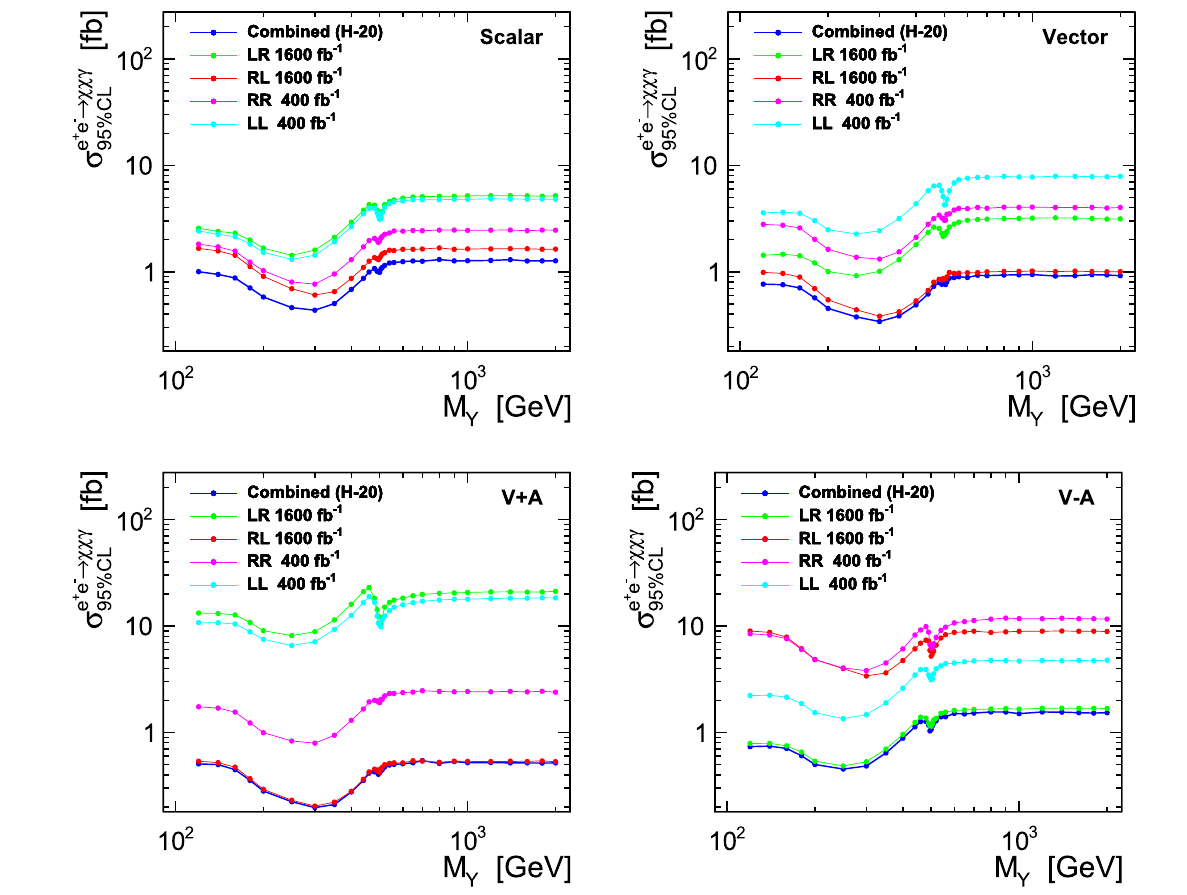
Fig. 9 Limits on the cross section for the radiative light DM pair-production processes with s -channel mediator exchange for 500GeV ILC. Different mediator coupling scenarios are considered, as indicated in the plot label (see Table 2 for details). Limits resulting from running with different beam polarisations and the combined limits are presented. Systematic uncertainties are not taken into